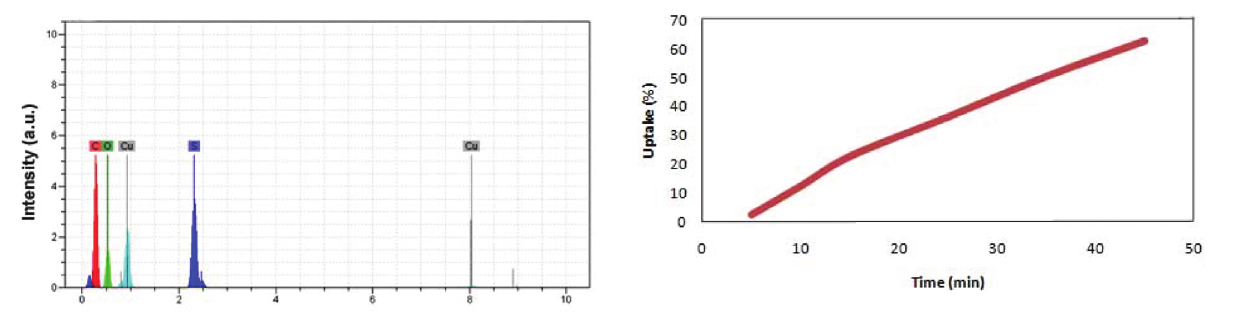
Figure 6: SEM of posnjakite nanopar- ticles in the presence of surfactant: (a) CTAB, (b) SDS and (c) PVP in 600 W and 15 min.